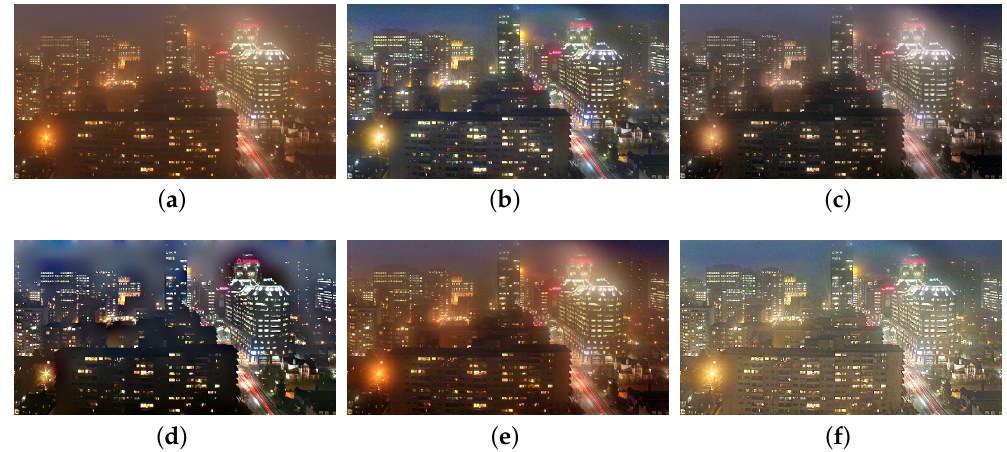
Figure 11. Comparisons with other nighttime dehazing methods on test image Cityscape .